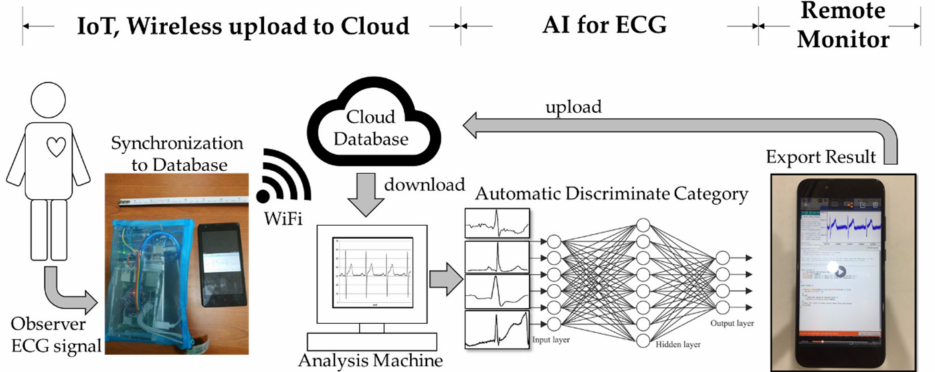
Figure 2. The workflow with combined AI and